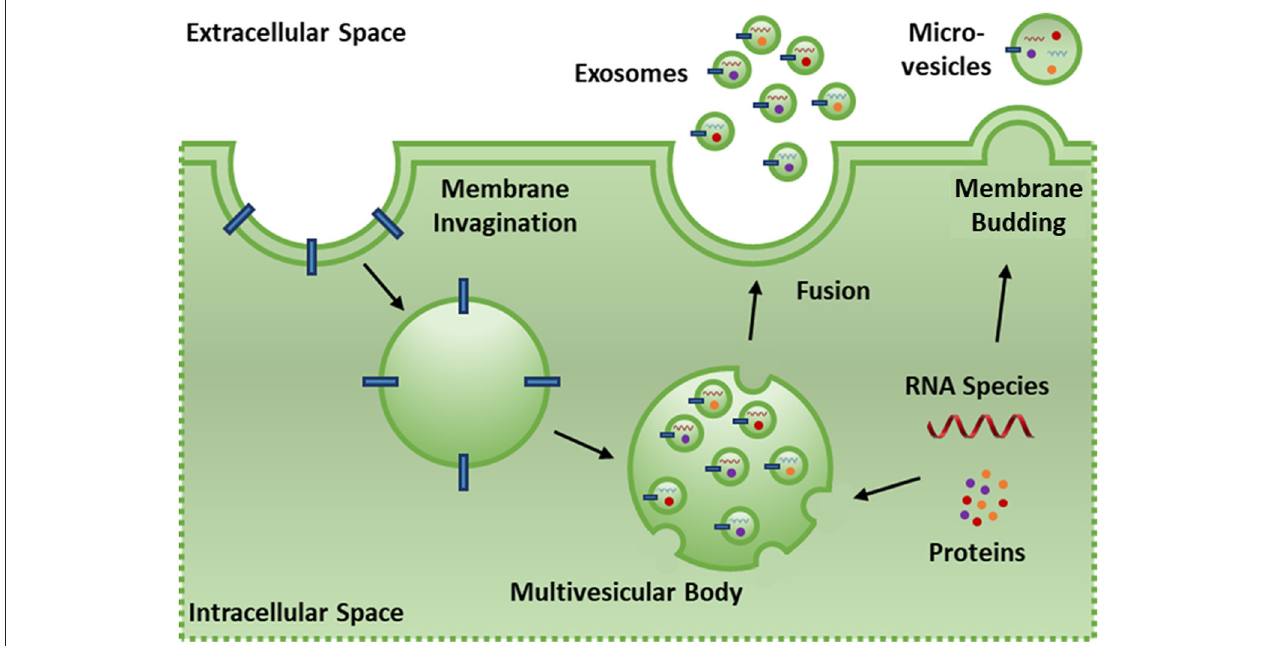
FIGURE 3 | Exosomes (30–200nm) are released by cells when intracellular multi-vesicle bodies form via invaginations of the cell membrane and are selectively loaded with endosomes containing protein, mRNA and miRNA. Fusion of the multi-vesicle body with the cell membrane releases these endosomes as exosomes. Micro-vesicles (200–1,000nm) are released via direct outward budding of the cell membrane and contain protein, mRNA and miRNA. The loading of microvesicle cargo is less selective than exosomes and membrane proteins are more reflective of the parent cell membrane due to direct budding.